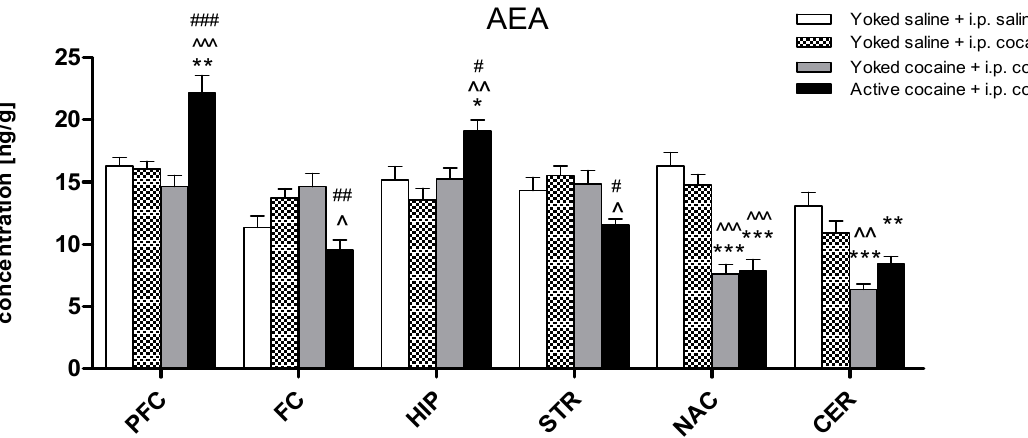
Figure 2. Levels of anadamide (AEA) in brain structures in rats previously self-administered cocaine (14 days) (Active cocaine) or which passively received cocaine (Yoked cocaine) or saline (Yoked saline) and underwent extinction training (10 days) and drug-induced reinstatement (10 mg/kg cocaine i.p. or saline i.p.). N = 7–8 rats/group. All data are expressed as the means ± SEM. * p < 0.05, ** p < 0.01, *** p < 0.001 vs. Yoked saline + saline i.p.; ^ p < 0.05, ^^ p < 0.01, ^^^ p < 0.001 vs. Yoked saline + cocaine i.p.; # p < 0.05, ## p < 0.01, ### p < 0.001 vs. Yoked cocaine + cocaine i.p. PFC—prefrontal cortex;